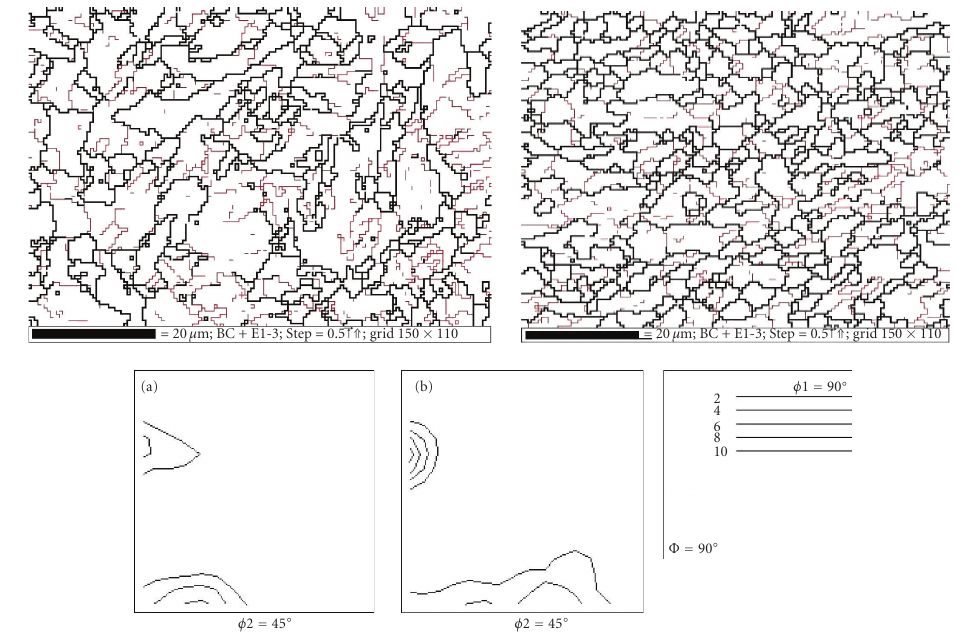
Figure 8: Microstructure orientation and texture component picture (a) original, (b) 5% tensile